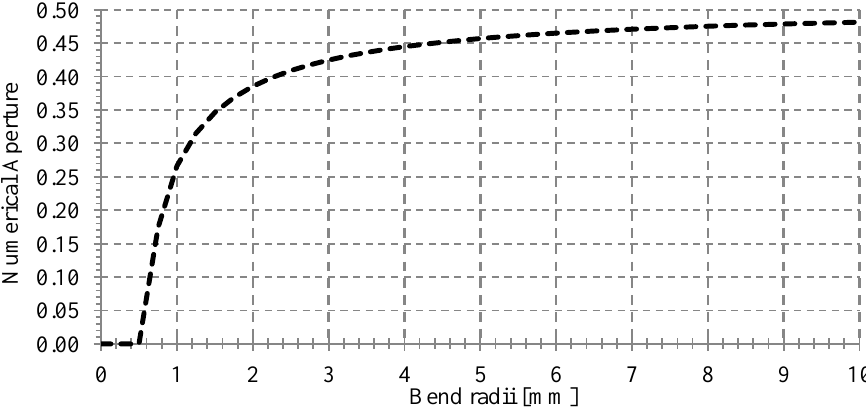
Figure 3. Local numerical aperture versus bend radius at , with ρ m and